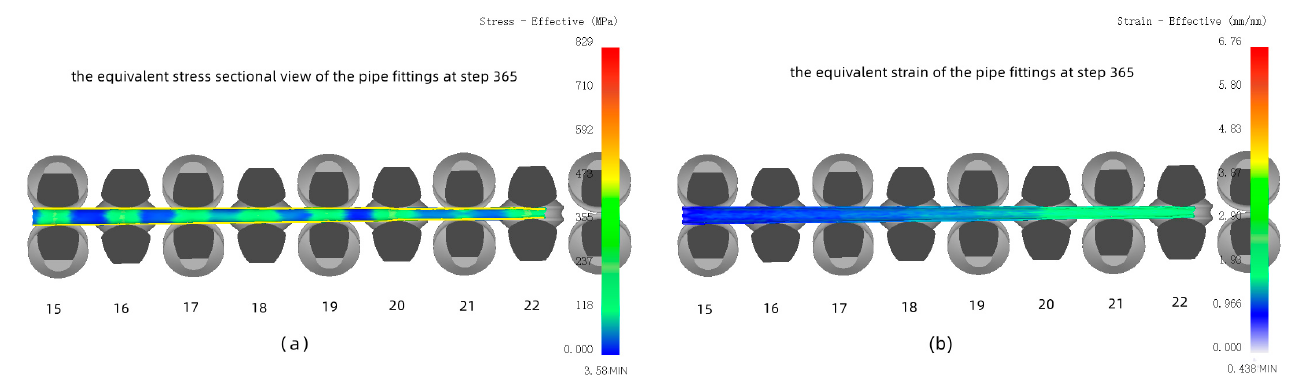
Figure 8. The equal effect diagram and equivalent strain diagram of part of the 28 tension reducing machines.